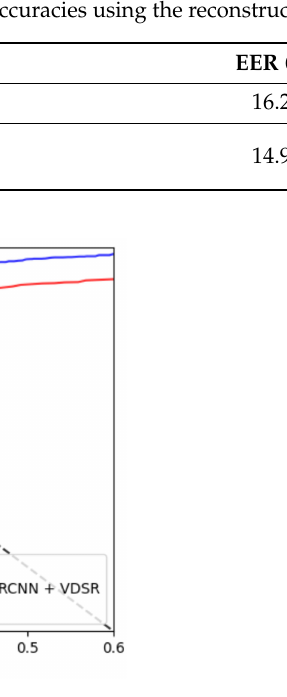
Figure 17. ROC curves of gender recognition accuracies with visible-light images.